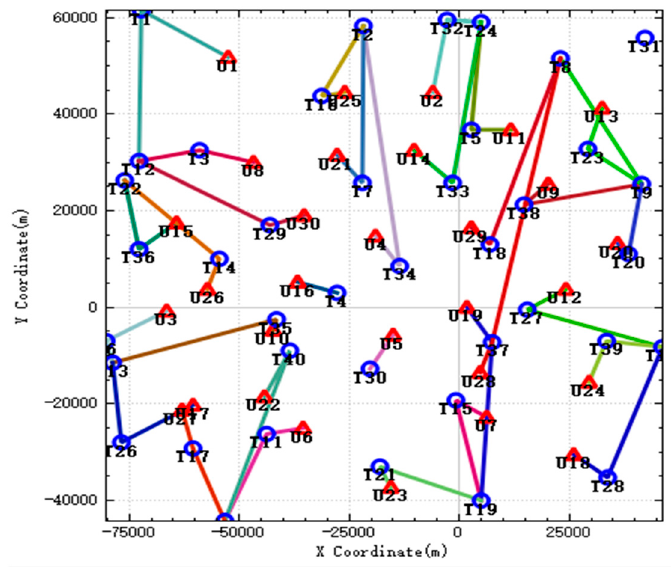
Figure 4. The result of UAV task allocation.